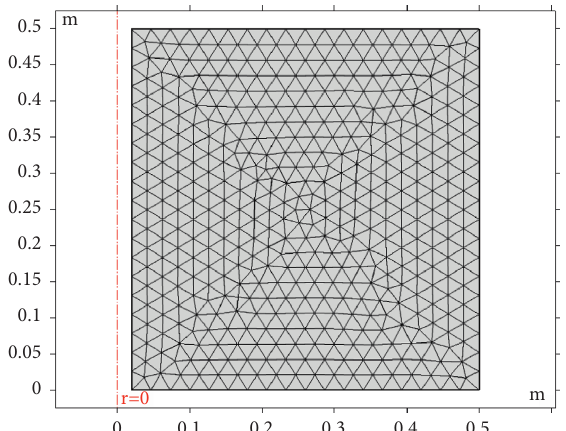
Figure 2: The meshing of the computational model.